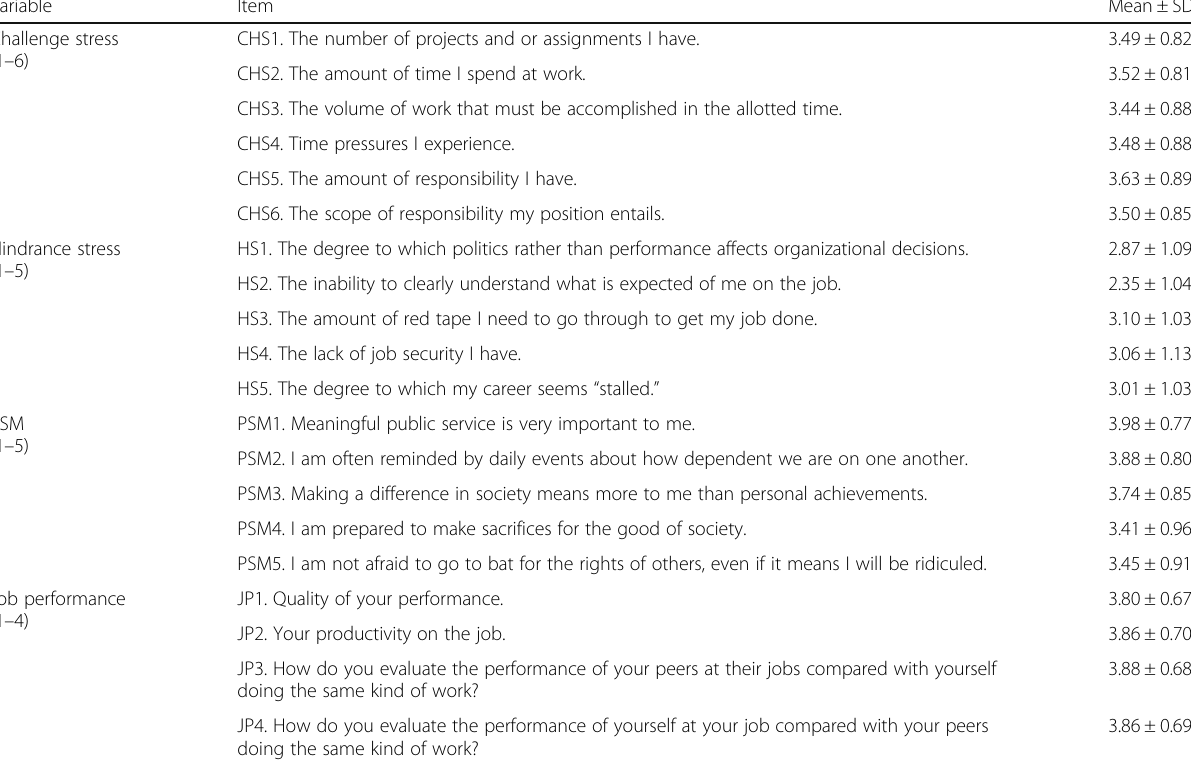
Table 2 Mean (SD) for challenge stress (CHS), hindrance stress (HS), public service motivation (PSM), and job performance (JP) items Variable